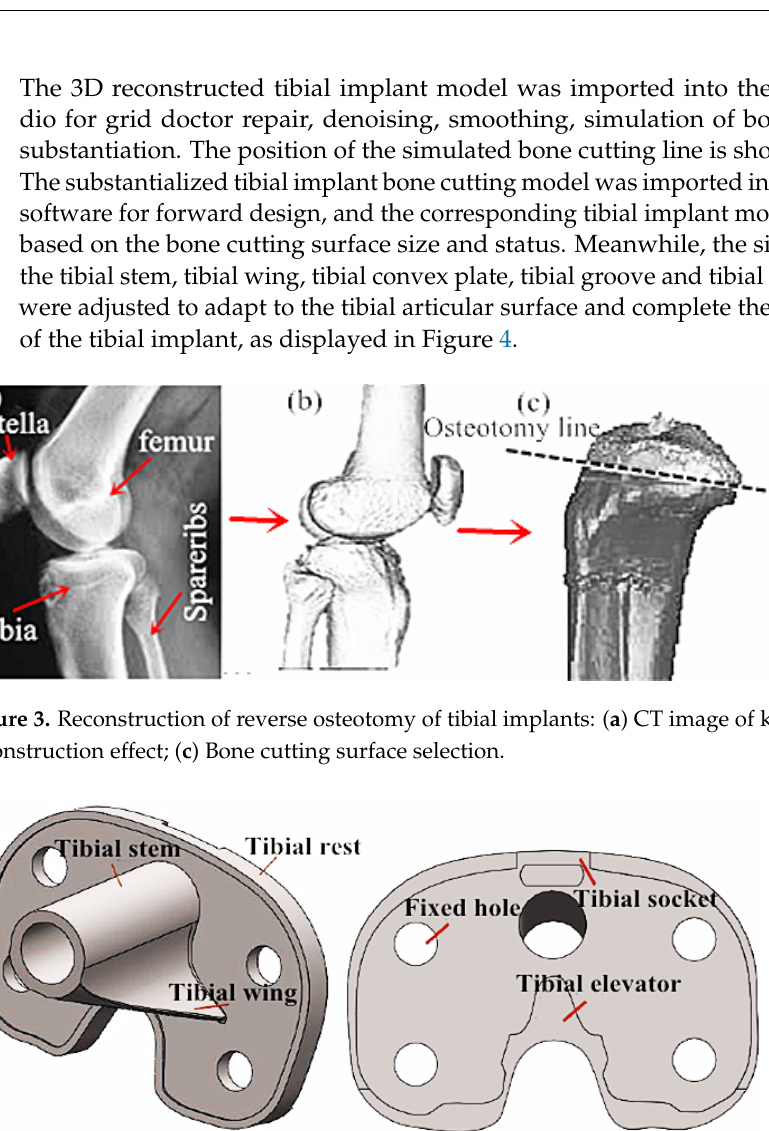
Figure 4. Solid model of personalized tibial implant: ( a ) Stereogram of tibial prosthesis; ( b ) Overlook of tibial prosthesis.